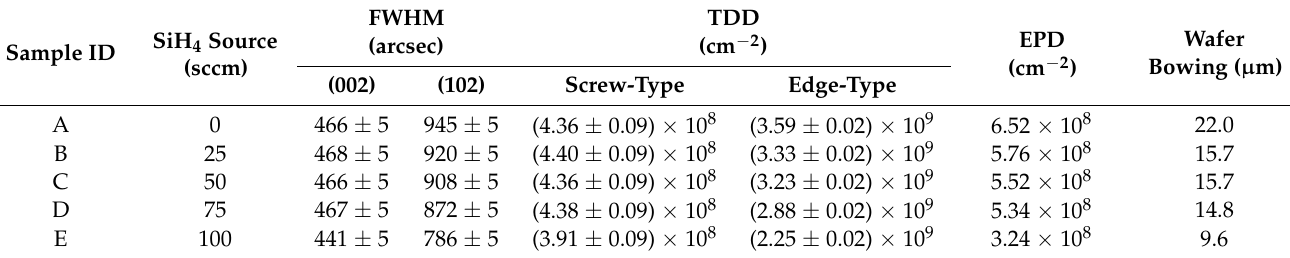
Table 1. Dependence of dislocation density on the SiH 4 flow rate by XRD and EPD analysis.